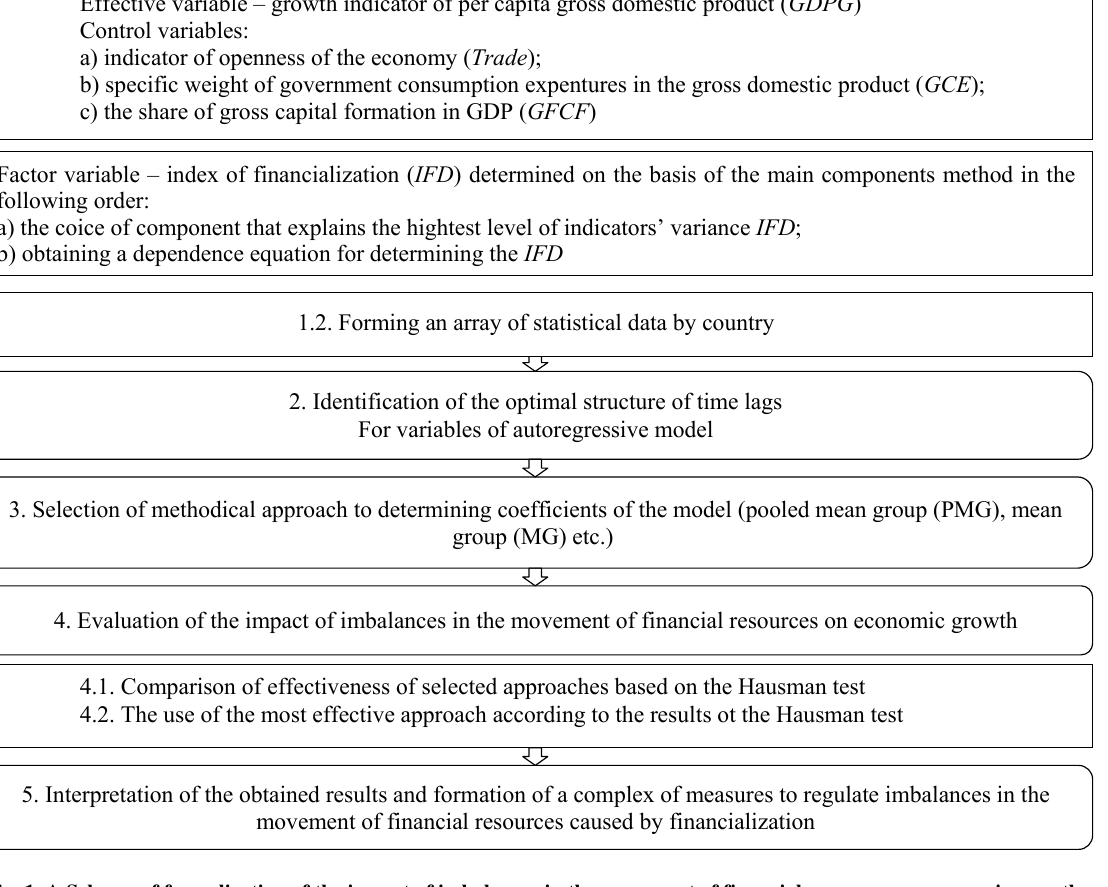
Fig. 1. A Scheme of formalization of the impact of imbalances in the movement of financial resources on economic